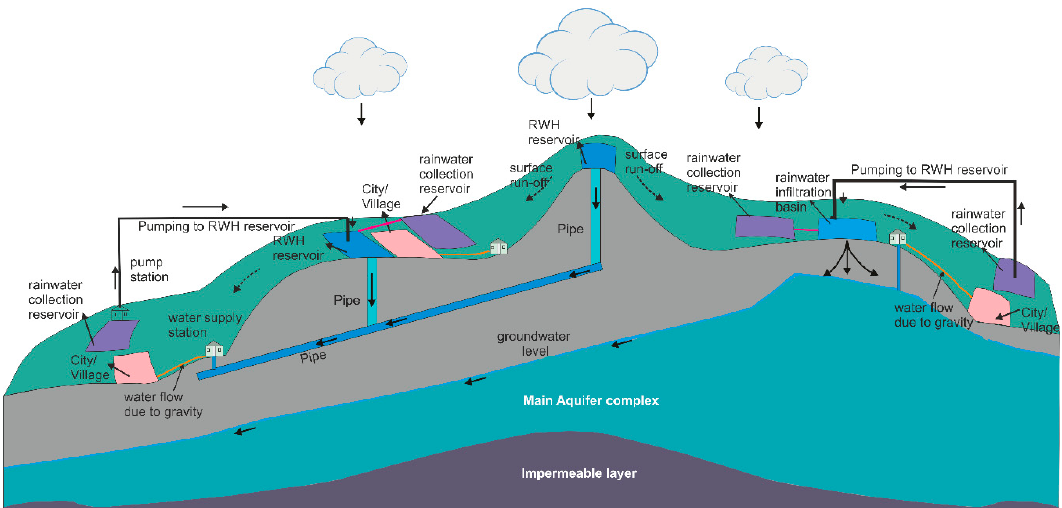
Figure 2. Schematic illustration of the Kilimanjaro concept: rainwater is harvested, locally stored in villages and cities, and then pumped for storage in stations on mountains. Water from the storage stations is then gravity ‐ fed to water treatment plants. The water is conveyed through a pipe network to avoid contact with fluoride ‐ rich geological materials. The diagram is not drawn to scale.